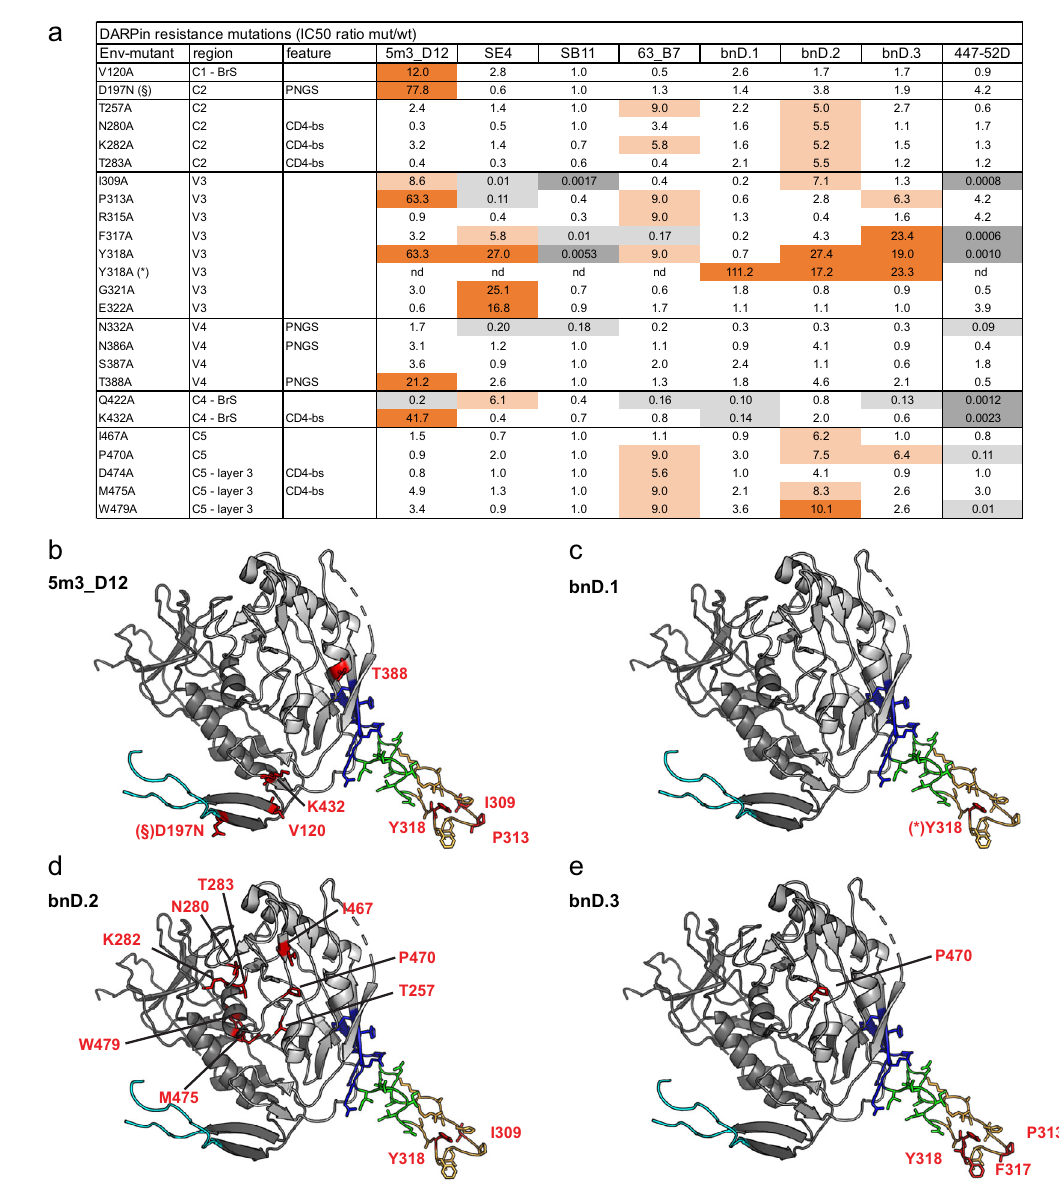
Fig. 4 Mutational scanning reveals key residues that determine sensitivity to V3 bnDs. Mutational scanning of gp120 was performed across a 130 Env- pseudovirus mutant panel (Supplementary Data 7 and 8). a Overview of Env mutants that lead to >5-fold increase in IC 50 compared to wt Env for at least one DARPin. For the DARPins, IC 50 values for each mutant represent geometric means from at least two independent experiments (Supplementary Data 8). IC 50 ratios (IC 50 mutant/IC 50 wt) are depicted. Light orange 5 < IC 50 -ratio<10; orange IC 50 -ratio>10; light grey 0.01 < IC 50 -ratio<0.2; dark grey IC 50 -ratio<0.01. PNGS: potential N-glycosylation site; CD4-bs: CD4-binding site; BrS: bridging sheet; C1-C5: Env constant regions 1-5; V1-V5: Env variable regions 1-5. b-e Structure of gp120 as in complex with sCD4 and CCR5 (PDB ID: 6meo; gp120 inner domain (dark grey), gp120 outer domain (light grey), V1V2 base (cyan), V3-base (dark blue), V3-stem (green), V3-crown (orange). Amino acid substitutions leading to a > 5-fold increase in the respective DARPin IC 50 compared to the wt Env are indicated in red. (*/§): Mutations with >5-fold increase in IC 50 identi fi ed in different Envs: BG505 (*) or JR-FL (§). JR-FL naturally lacks the glycosylation site at position